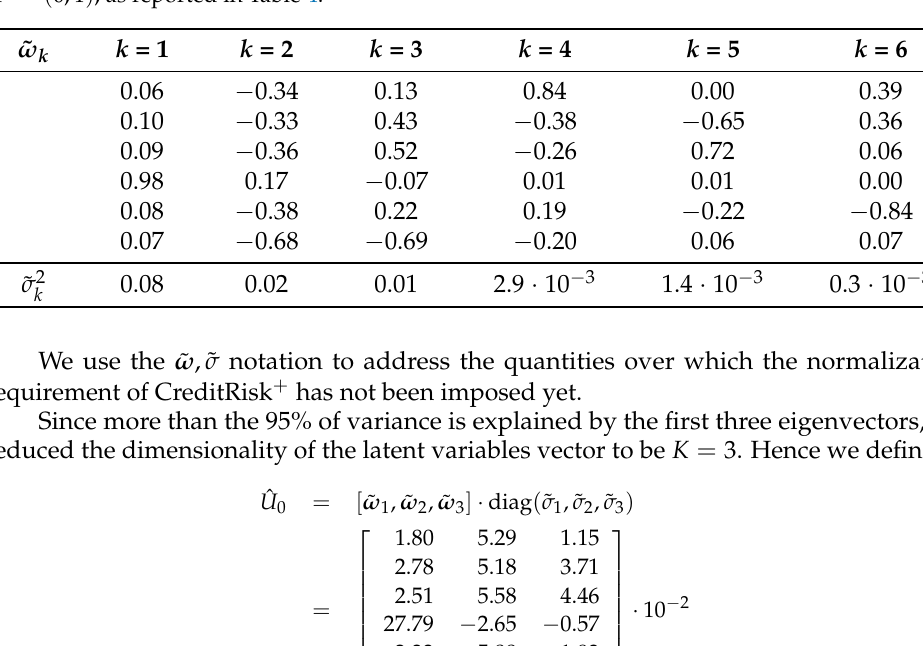
Table 7. Set of eigenvalues ˜ σ k and eigenvectors ˜ ω k obtained by the eigenvalues decomposition of ˆ A ( E ,4 ) ( 0,1 ) , as reported in Table